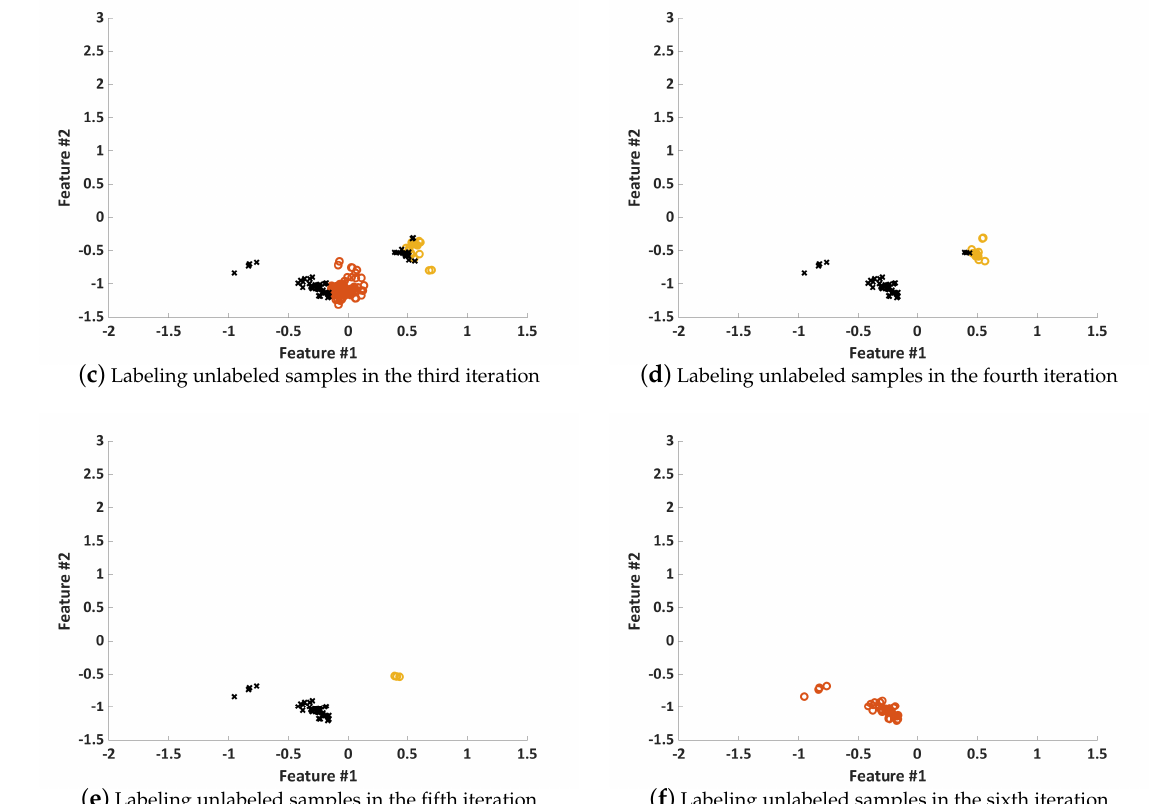
Figure 3. The convergence of the MMD-SSL